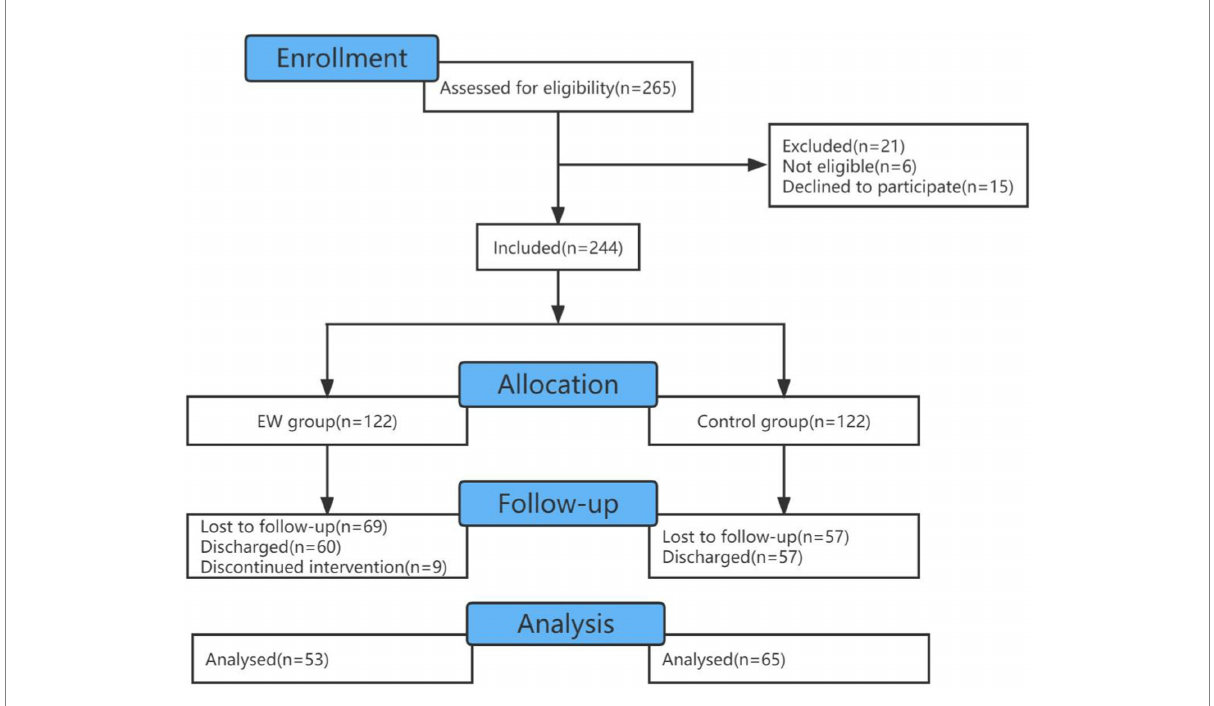
FIGURE 1 Flow diagram to indicate the included and excluded